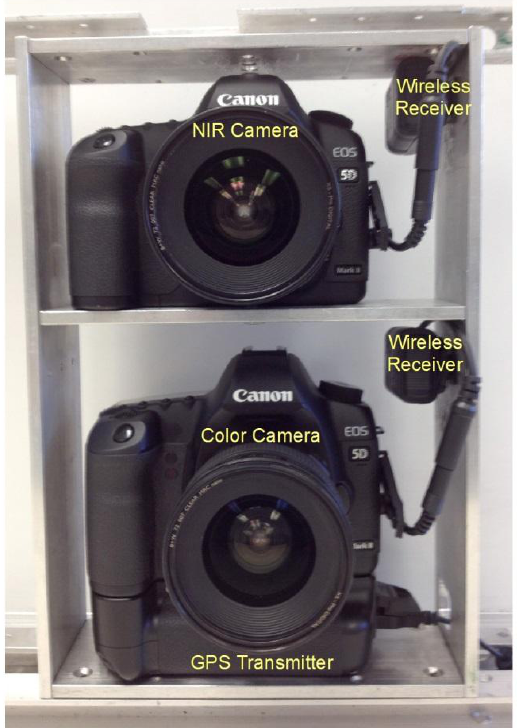
Figure 1. A two-camera multispectral imaging system mounted on an aluminum